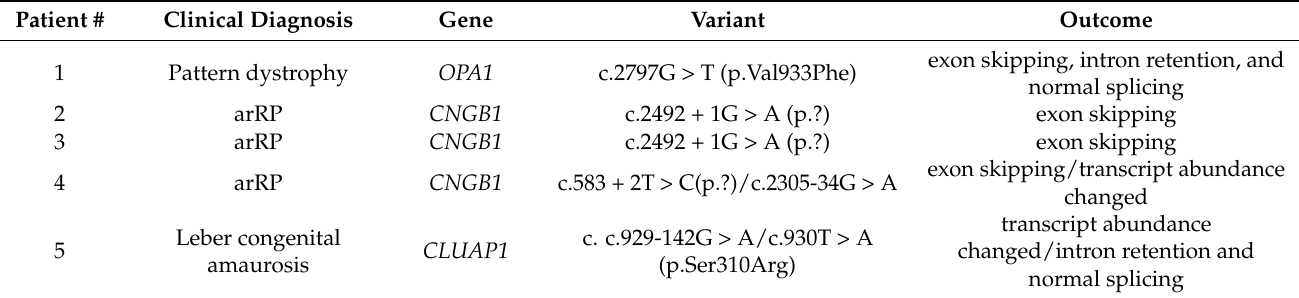
Table 1. Patient VUS and splice assay